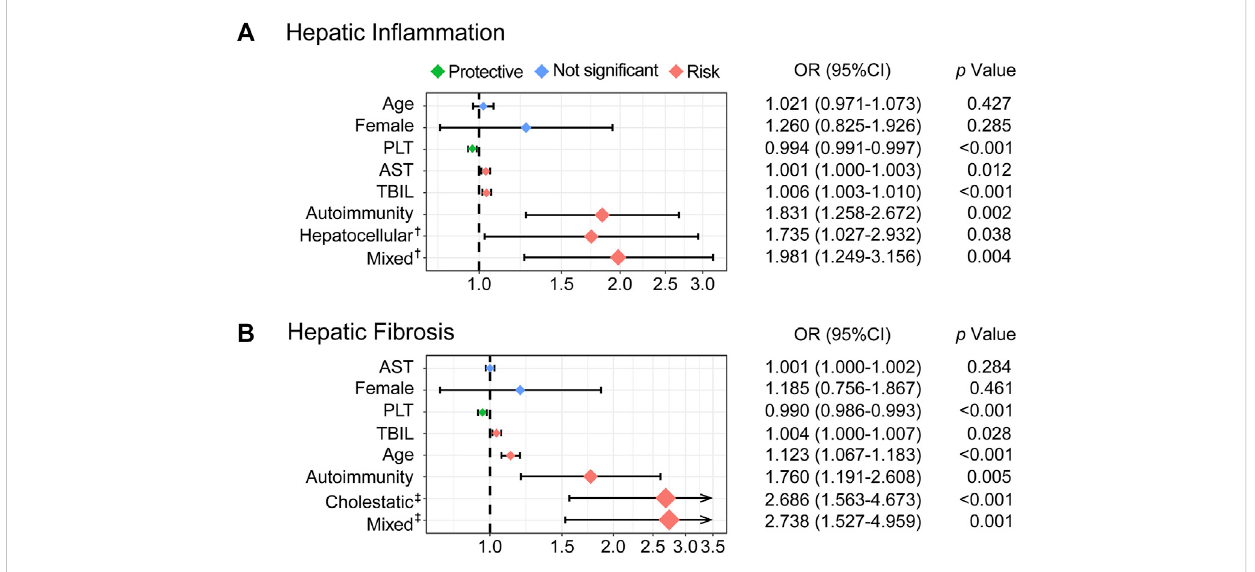
FIGURE 4 Forest plots based on multivariable ordinal polytomous logistic regression analysis. The X -axis was transformed as a log scale (A) . The risk factors associated with hepatic in fl ammation (B) . The risk factors associated with hepatic fi brosis. The colored solid diamonds represent the OR and the black lines show 95% CI.OR, odds ratio; CI, con fi dence interval; AST, aspartate transaminase; TBIL, total bilirubin; PLT,